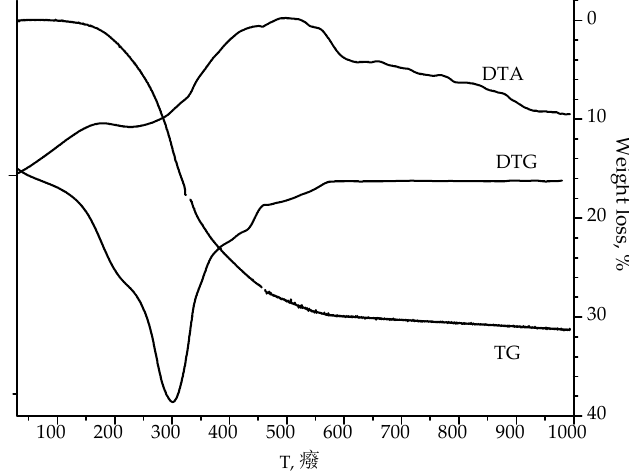
Figure 1. TG/DTA curves of as-synthesized 20SnO 2 /Al 2 O 3 Figure1 . TG/DTA curves of as-synthesized 20SnO 2 /Al 2 O 3 sample.